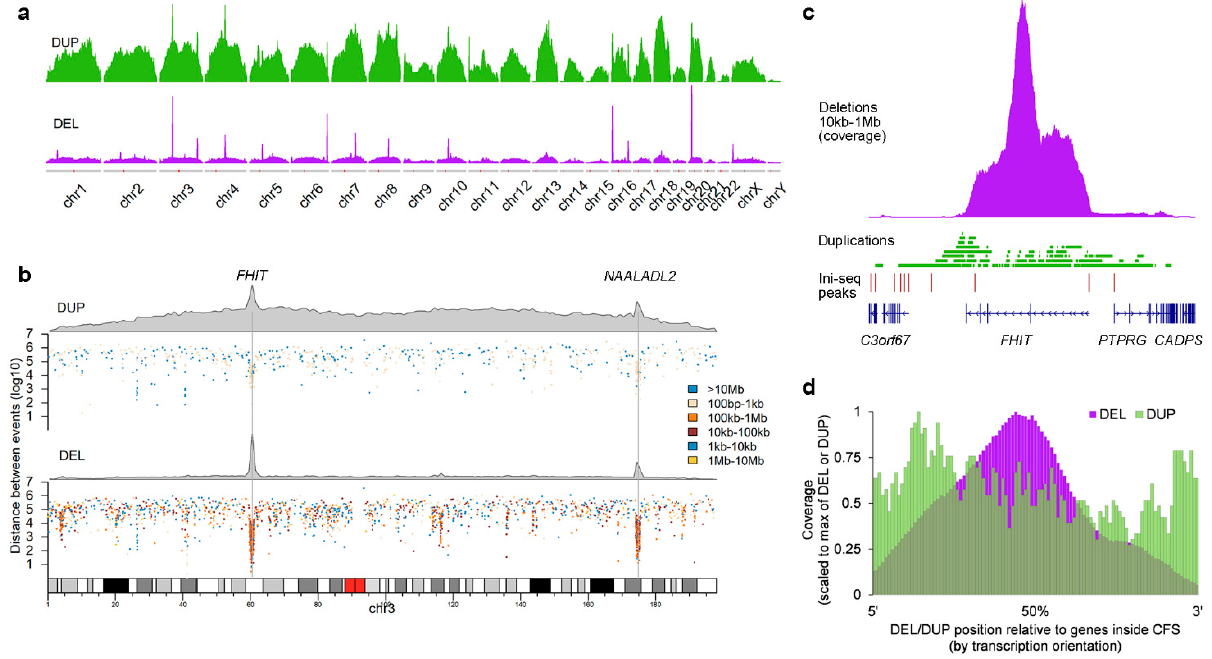
Figure 3. Spatial and size preference for duplications in mCRC. ( a ) Density plots of DELs and DUPs in mCRC. Each track is scaled to the maximum density within that track. ( b ) DELs and DUPs in chromosome 3, each showing a density plot and a rainfall plot to indicate sizes. ( c ) More detailed DEL/DUP locations for the FHIT gene. ( d ) Relative position of DELs/DUPs in hotspot CFS regions, corrected for transcription orientation of the genes.